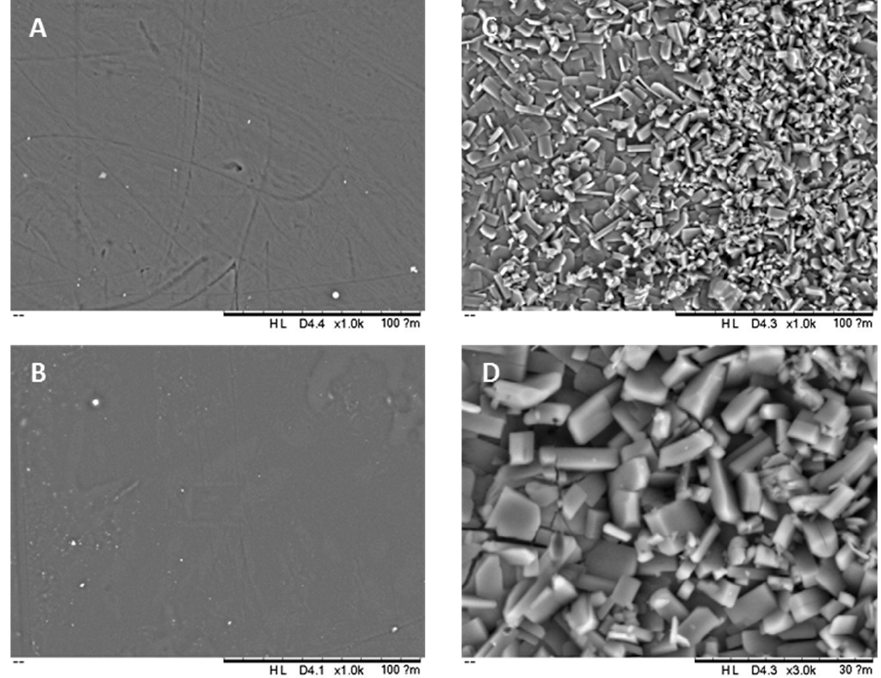
Figure 2. SEM images of the surface of 3D-printed tubular grafts: blank ( A ), 5% ( w / w ) ASA ( B ); 10% ( w / w ) ASA ( C ); Higher magnification of 10% ( w / w ) ASA ( D ).